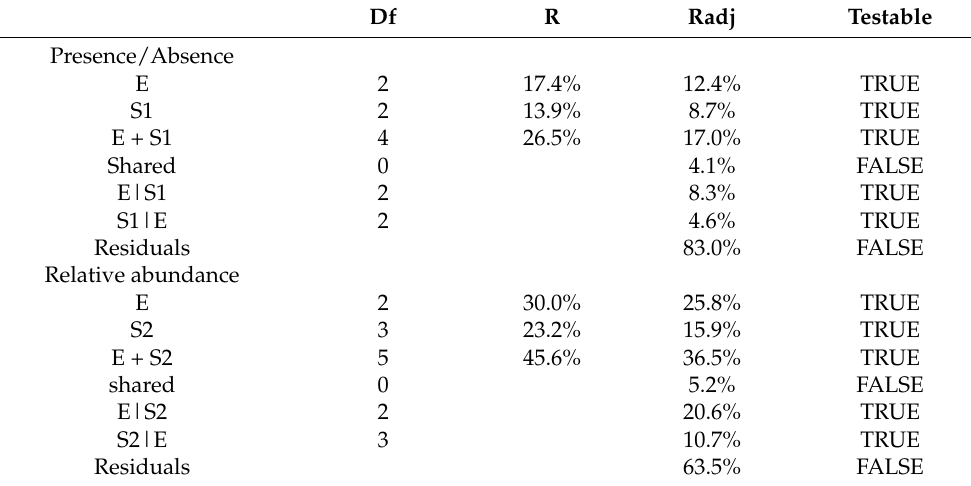
Table 4. Variance partitioning of cladoceran community structure. (E, selected environmental variables base on forward selection in redundancy analysis including conductivity and DO; S1, significant positive PCNM variables, including V1 and V8; S2, significant positive PCNM variables, including “V1”, “V4”, and